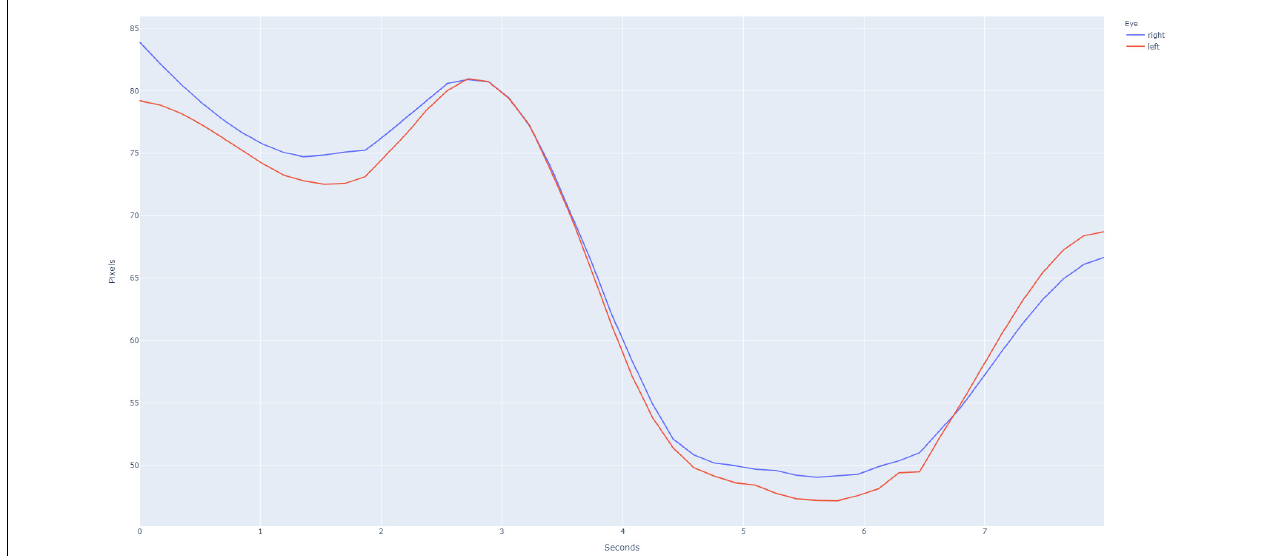
FIGURE 2 | Example pupillary light reflex (PLR) curve for a normal subject, as is evidenced by the large amount of constriction after the light stimulus is applied at the 3 s time point. Binocular recording of the PLR is obtained using the PupilScreen application such that the simultaneous constriction of both the right eye (blue curve) and the left eye (red curve). The current generation of PupilScreen produces PLR curves in terms of pixels and seconds.